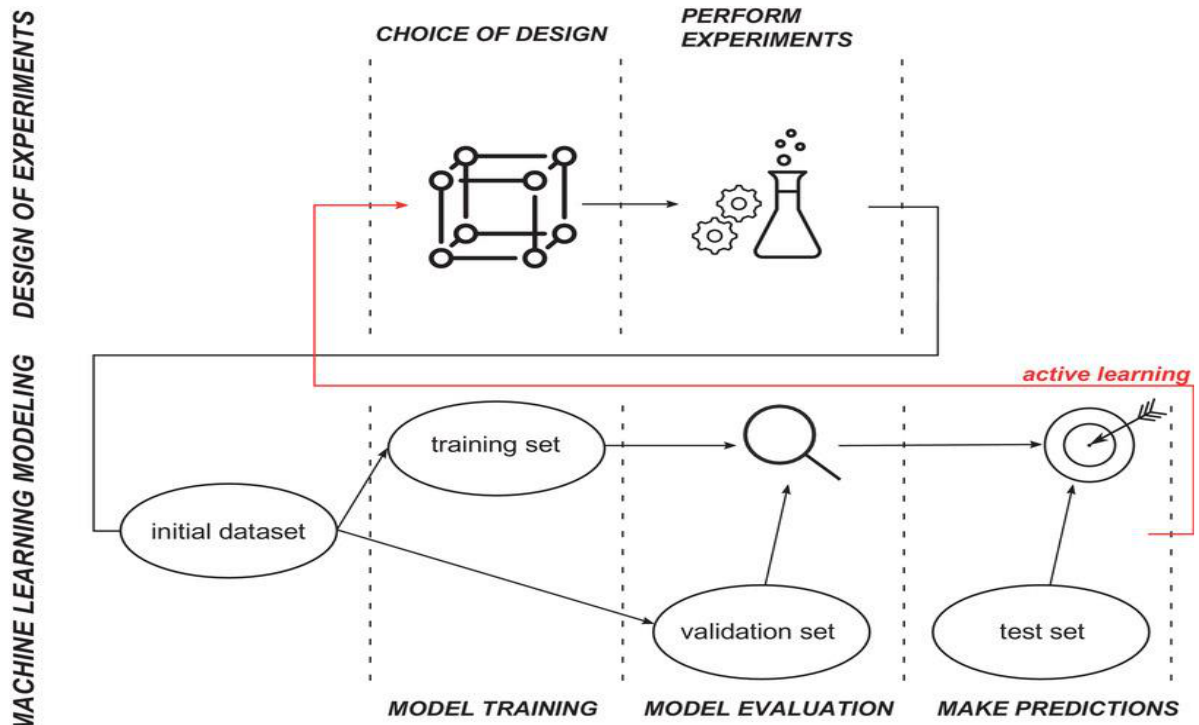
Figure 10. Summarised workflow, describing the link between ML and the DoE, where the DoE data is being used as an input for the ML model. Active learning can occur when the ML result is used as an input suggestion to design a new experiment. Reprinted with permission from Ref. [108]. 2021, John Wiley and